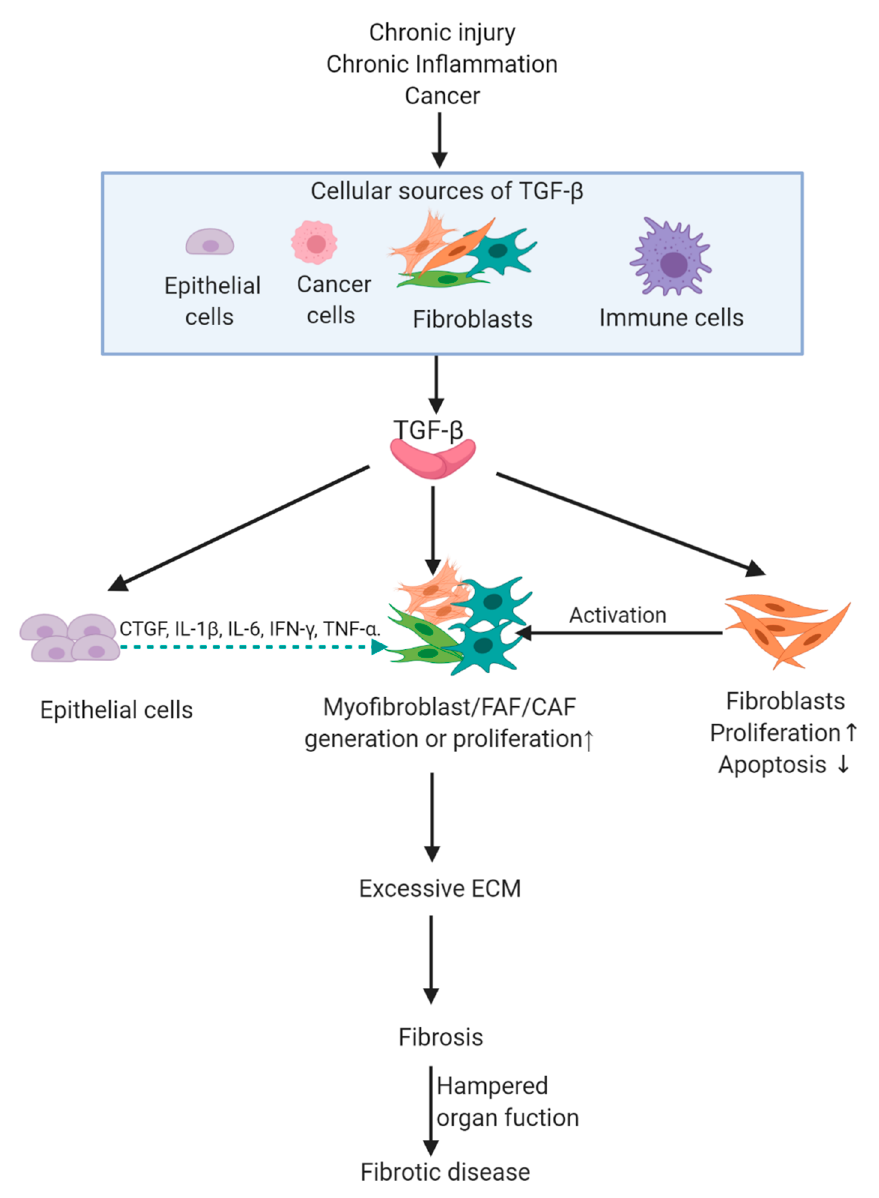
Figure 2. Downstream events of chronic injury / inflammation / cancer-induced TGF- β expression contributing to fibrotic disease. TGF- β is increased in the microenvironment of chronic injury / inflammation, and cancer. Once activated by TGF- β ligands, epithelial cells can secrete more fibrotic factors, such as CTGF, to increase fibroblast proliferation. Fibroblasts become activated and turn into myofibroblasts, FAFs, or CAFs, and these cells are important e ff ector cells that can produce excessive ECM, leading to fibrosis and ultimately fibrotic diseases when organ function is hampered. The green dotted arrow indicates cytokine paracrine interaction. CTGF, connective tissue growth factor; IL-1 β , interleukin-1 β ; IL-6, interleukin-6; IFN- γ , interferon- γ ; TNF- α , tumor necrosis factor- α ; FAF, fibrosis-associated fibroblast; CAF, cancer-associated fibroblast; ECM, extracellular matrix.